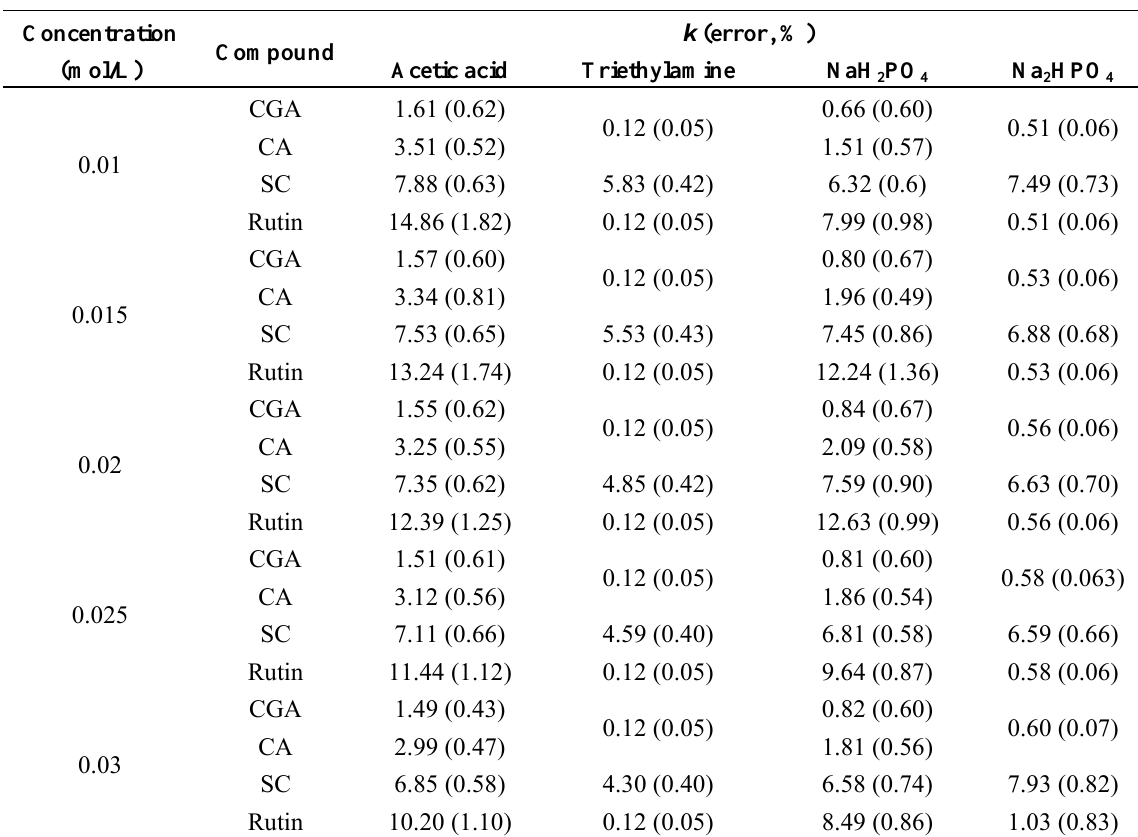
Table 1. Effect of concentrations of different mobile phase additives on retention factors. CGA: chlorogenic acid; CA: caffeic acid; SC: scoparone.